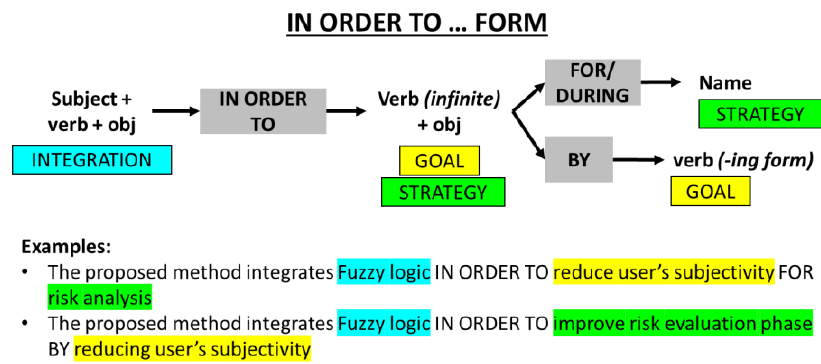
Figure 1. Common uses of “in order to …”